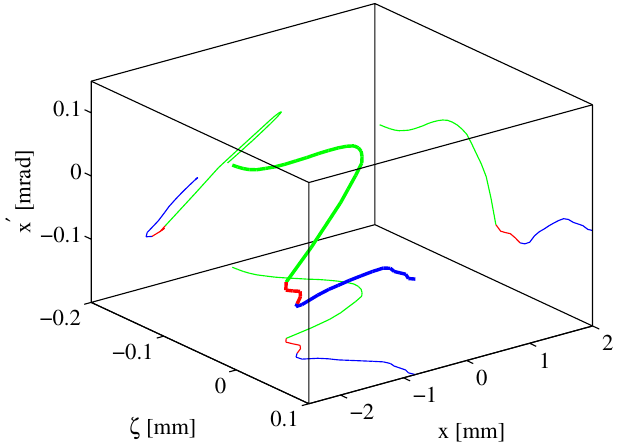
FIG. 15. (Color) Three-dimensional representation of the slice centroid as a function of the longitudinal coordinate (cid:2) (bold curve). Green: bunch tail; red: current spike; blue: electrons in front of the current spike. The thin curves show the projections of the centroid curve onto the ð x; x 0 Þ , ð x; (cid:2) Þ , and ð x 0 ; (cid:2) Þ planes, respectively. Note that the bunch tail is truncated at (cid:2) ¼ (cid:8) 0 : 2 mm